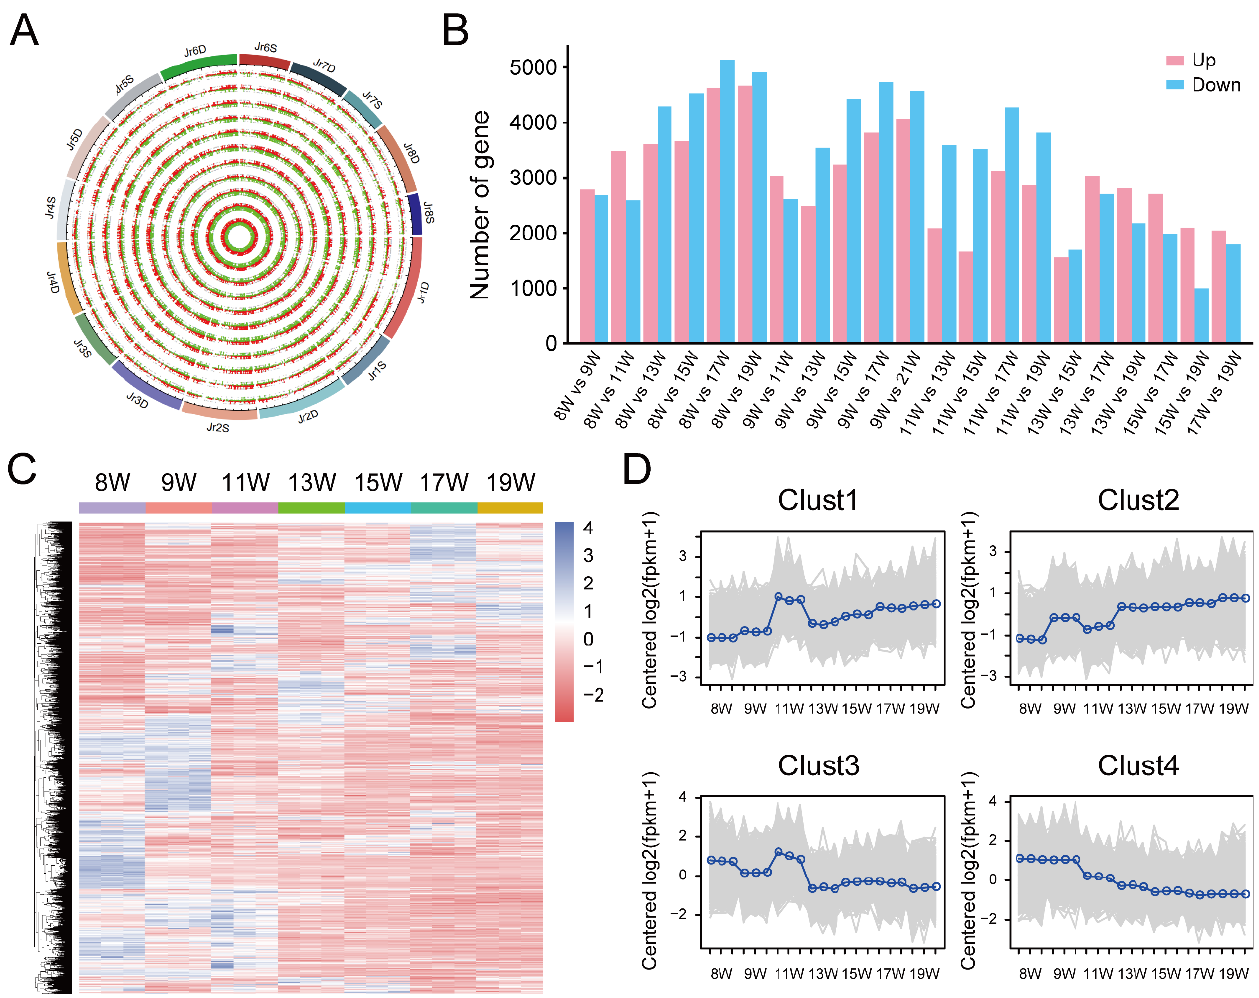
Figure 3. Identification of differentially expressed genes (DEGs). ( A ) The circos plot shows the distribution of DEGs at a genome-wide scale. These rings from outside to inside show genomic positions (1st), up- and downregulated gene density of each group; ( B ) the number of up- and downregulated genes; ( C ) The heatmap of DEGs in which each column represents one sample, and each row represents one DEG. Gene expression level was transformed by Z-score; ( D ) the line charts show the trend of gene expression level. The genes were divided into four groups (Cluster 1 – 4).